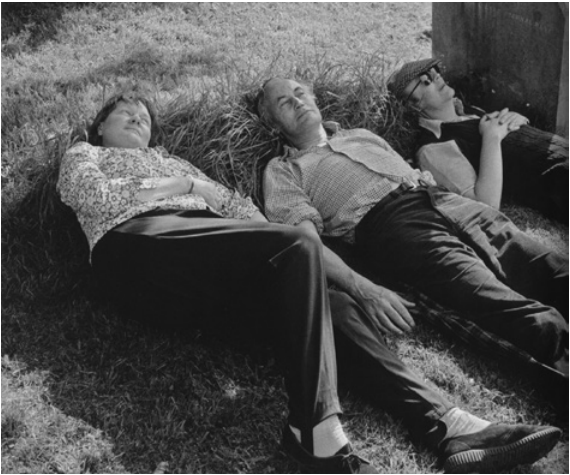
Figure 1. Iris Murdoch, Reynolds Stone and John Bayley relaxing in a churchyard (Source: By permission of The Estate of Reynolds and Janet